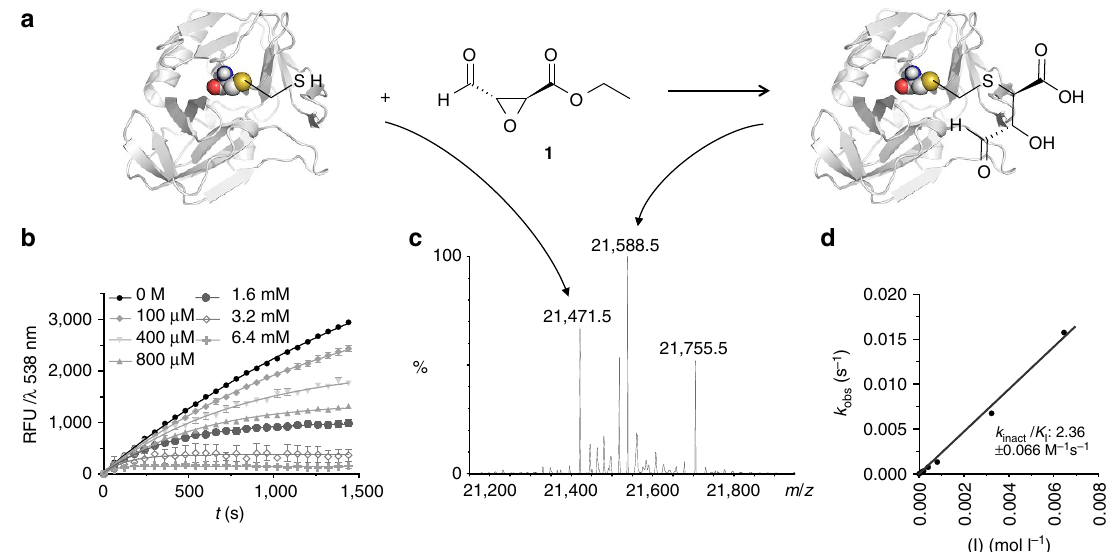
Figure 2 | Development of the bis-electrophilic warhead 1. ( a ) Deactivation of Coxsackie virus 3C protease by reaction with bis-electrophilic warhead 1 . Reaction scheme. ( b ) Inhibition of the protease in the FRET-based enzyme activity assay at various concentrations of 1. ( c ) Deconvoluted ESI-mass spectrum of the reaction of the protease with 1. The mass of the unmodified protein, 21,471.5Da, is shifted to a main peak at 21,588.5Da, corresponding to the mass of the protein þ 1 after cleavage of the ethyl ester. The peak at 21,755.5 corresponds to the protein mass þ 1 þ Tris (buffer)–water. ( d ) Deactivation of the protease is quantified as relative inhibition, the observed deactivation rate, k obs , plotted against inhibitor concentration. The slope of the linear regression curve of the k obs values plotted against the corresponding concentration value yields the k inact / K I -value for compound 1 and equals 2.4 ± 0.1M (cid:2) 1 s (cid:2) 1 . Table 1 | Synthesized inhibitors 1–21 and their k inact / K I or IC 50 values with Coxsackie 3B virus 3C